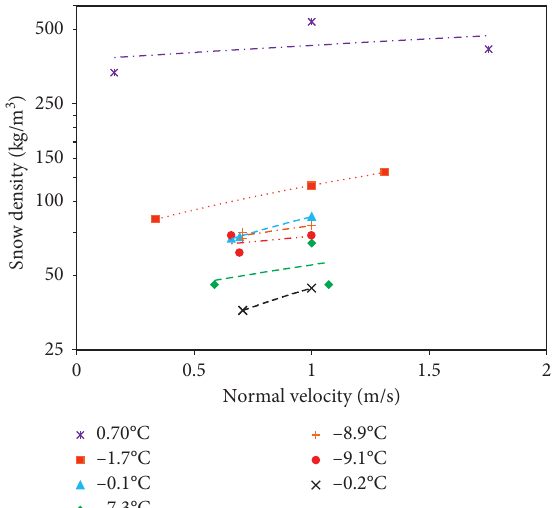
Figure 4: Snow density measured during different events as a function of wind velocity normal to the surface and precipitation temperature. In higher wind velocities, snow layers compress more effectively and snow density increases. Temperature and humidity are other factors that affect snow